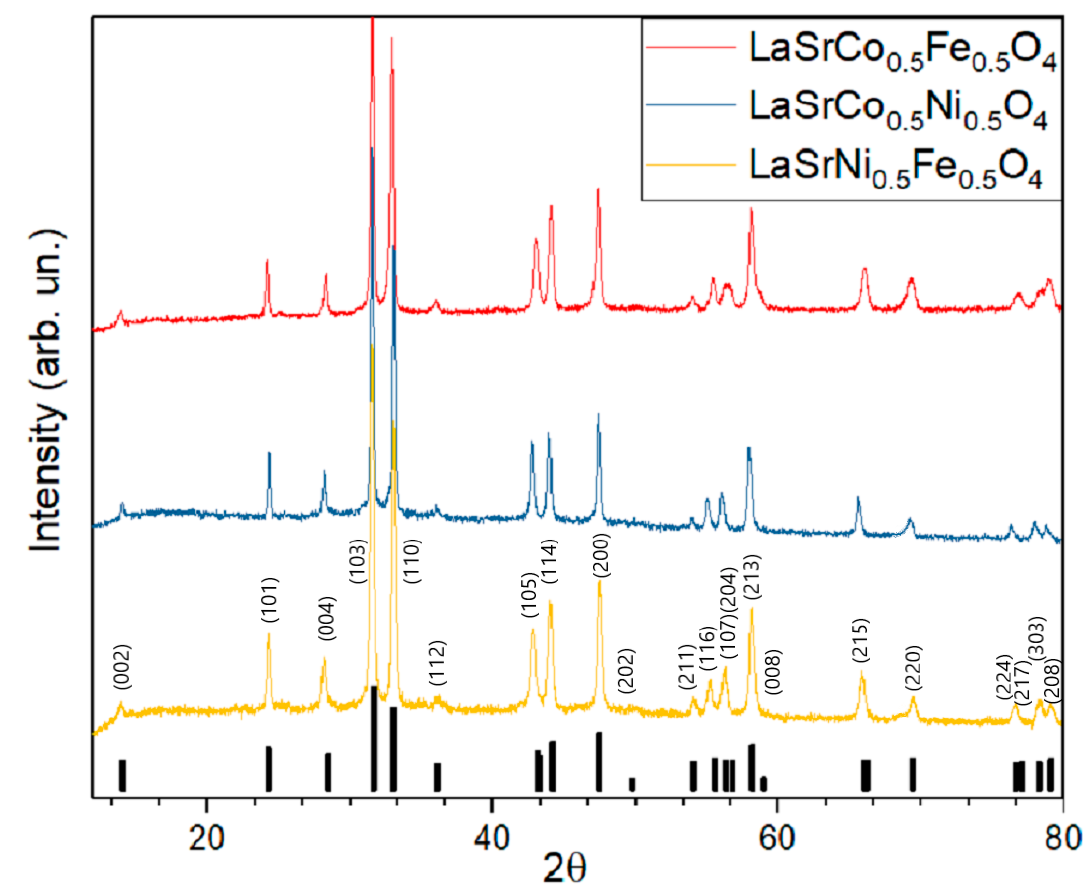
Figure 2. Diffractograms of LSNF, LSCF and LSCN prepared by spray-pyrolysis. Annealing at 850 °C, 12 h. Table 1. Unit cell parameters and calculated crystalline size of the RP phases in the synthesized